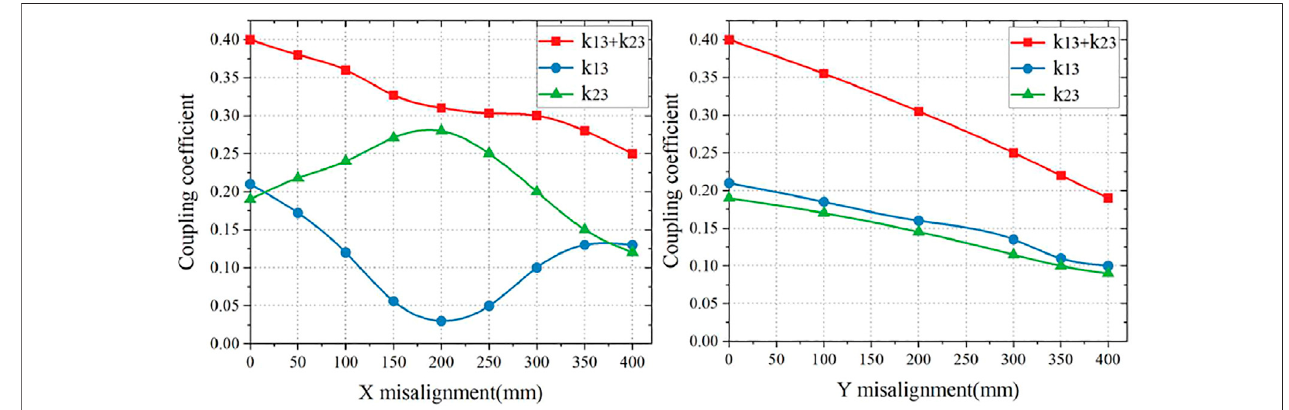
FIGURE 13 | Variation of k with misalignment in X and Y directions.